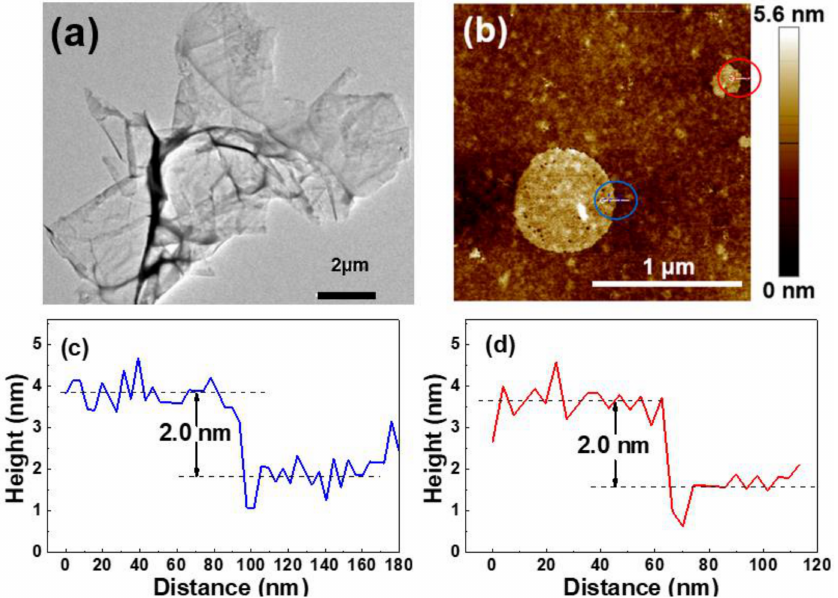
Figure 3. Morphology of PSS-G. ( a ) TEM images of PSS-G; ( b ) AFM images of PSS-G; height profiles of the PSS-G in ( c ) the blue circled region and ( d ) the red circled region shown in ( b